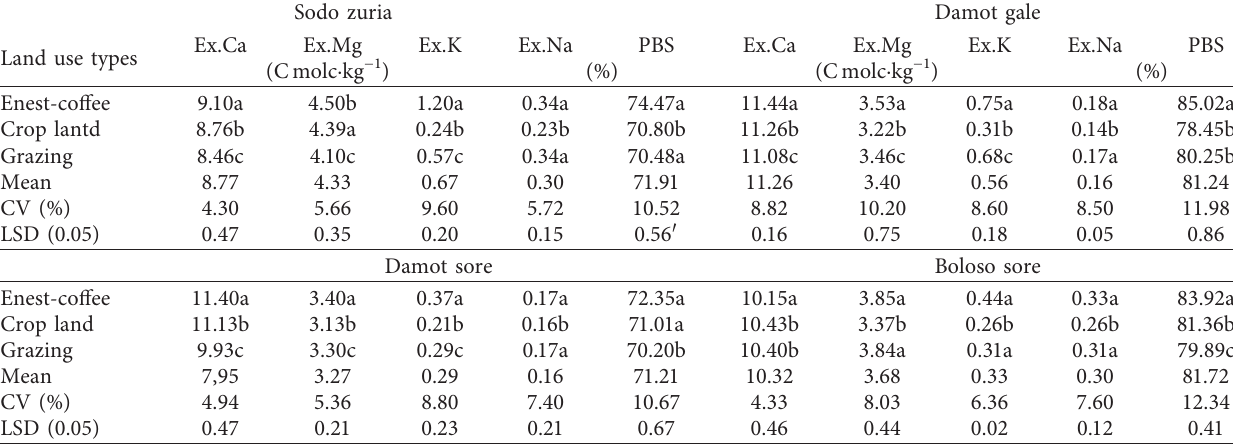
Table 4: Mean values ( n � 108) of exchangeable base and percentage of base saturation in different location and land use types of study